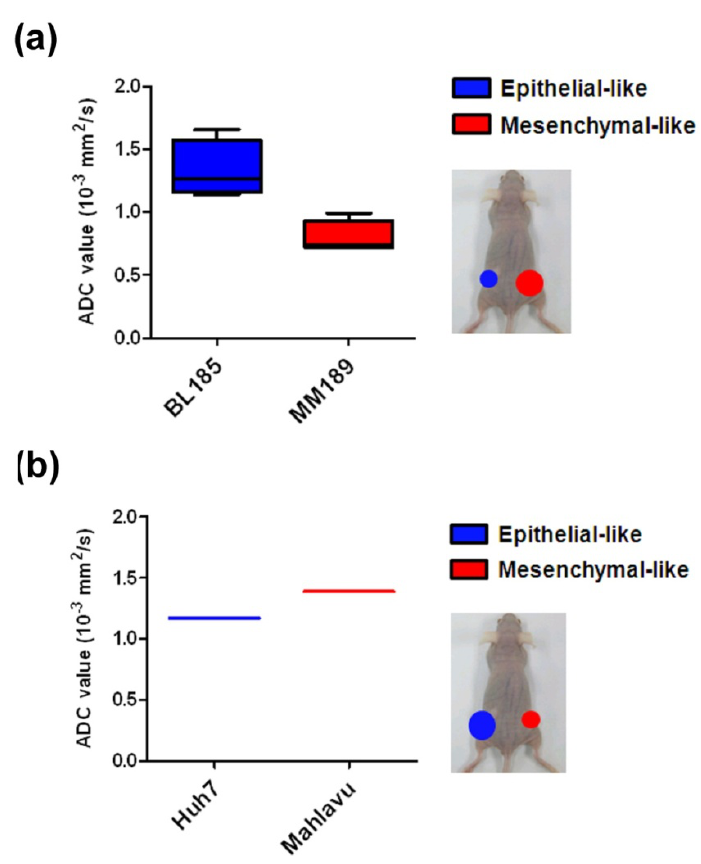
Figure 4. Comparison of ADC values in xenografted tumors from two different cell lines. ( a ) BL185 and MM189 subcutaneous tumors were generated from different numbers of injected cells. MM189 tumors showed significantly lower ADC values than those in BL185 tumors ( n = 4); and ( b ) Huh7 and Mahlavu subcutaneous tumors were generated from equal numbers of injected cells. The Mahlavu tumor demonstrated an ADC value higher than that in the Huh7 tumor ( n =